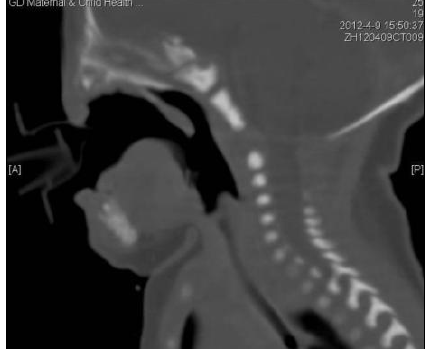
Figure 3: CT scan showing high arched palate, nostril atresia, the hypoplasia of bilateral maxillary sinus and ethmoid